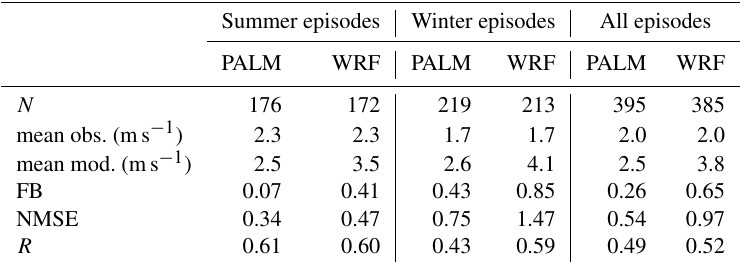
Table 5. Comparison of 1h average wind speed measured on the rooftop of FSv with WRF and PALM results for the same